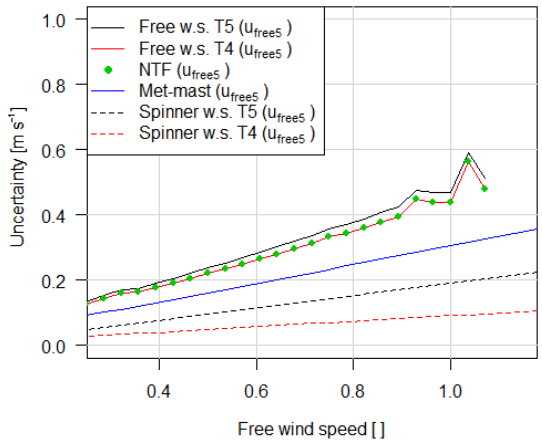
Figure 18. Uncertainty in wind speed. The met-mast wind speed includes 2% additional uncertainty due to lack of site